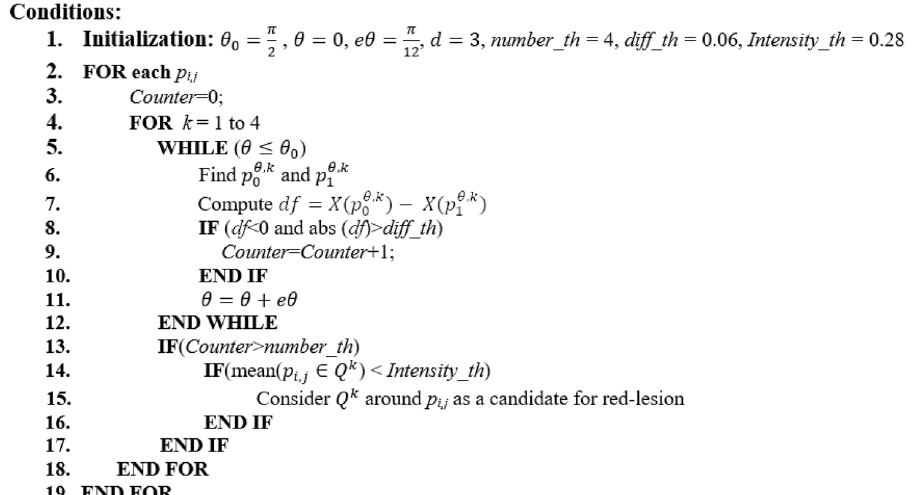
Figure 4. Pseudo-code for pixel-wise